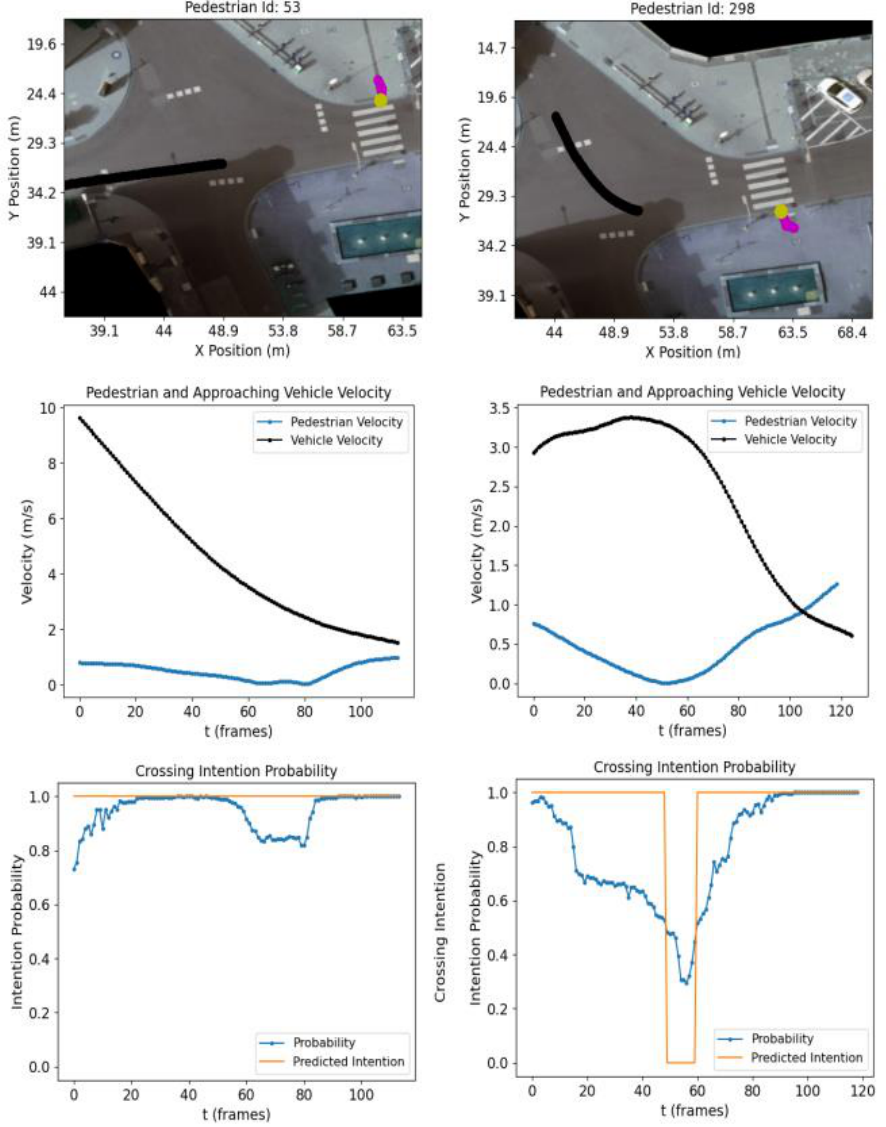
Figure 8. Intent prediction and velocity (plus approaching vehicle velocity) for pedestrians 53 ( left ) and 298 ( right ) from recording #18.